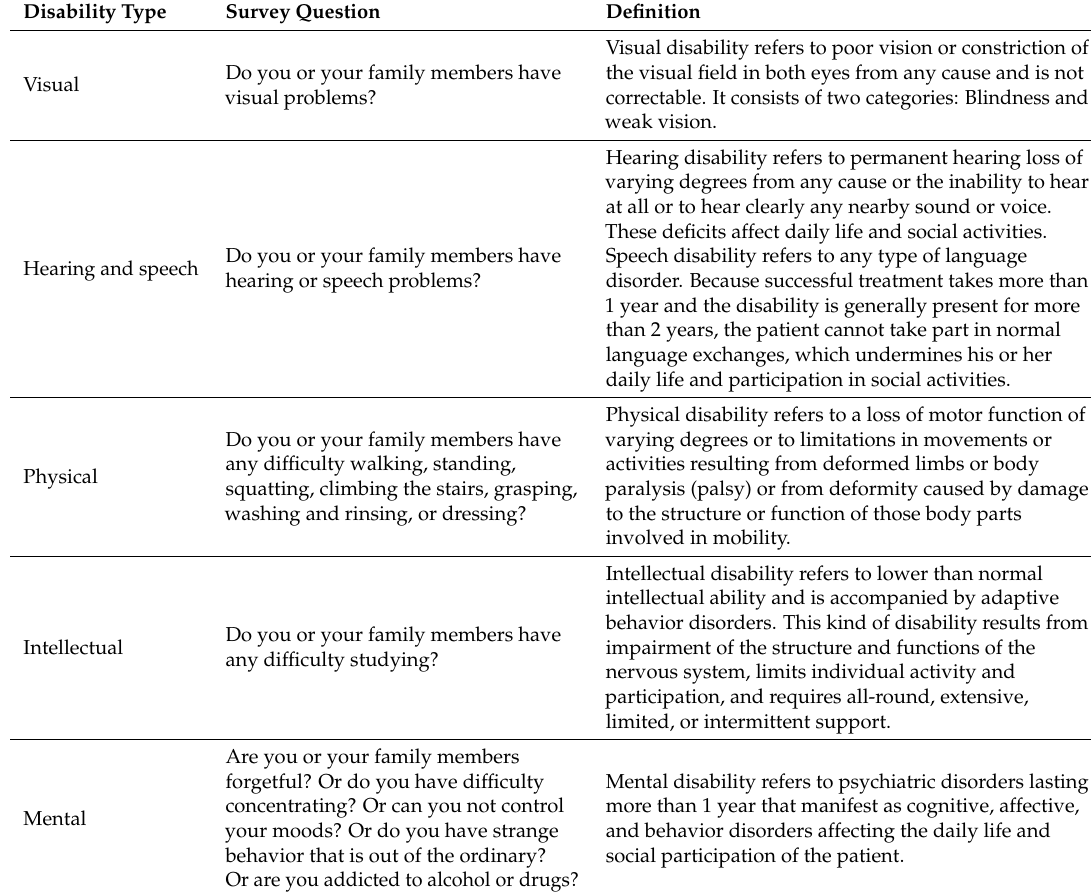
Table 1. Study definitions for different disability types and their corresponding survey questions